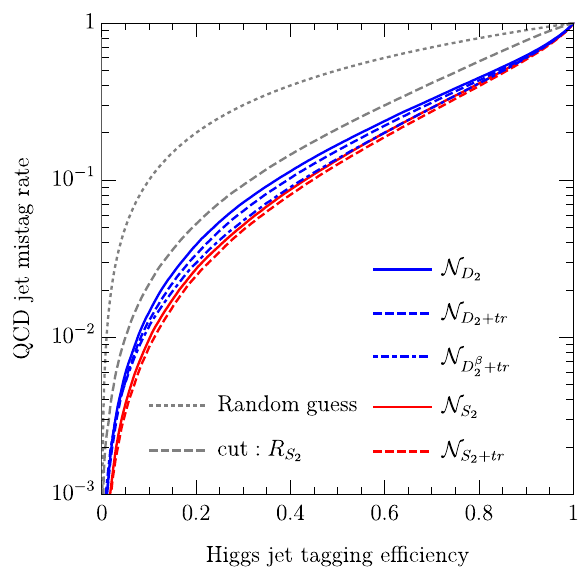
Figure 6 . ROC curves of ANN classi(cid:12)ers for Higgs jets and QCD jets with inputs eq. (4.1), eq. (4.3), eq. (4.4), eq. (4.5), and eq. (4.6). We overlay the cut-based ROC curves of R S (cid:12)gure 5 as a gray dashed line for a